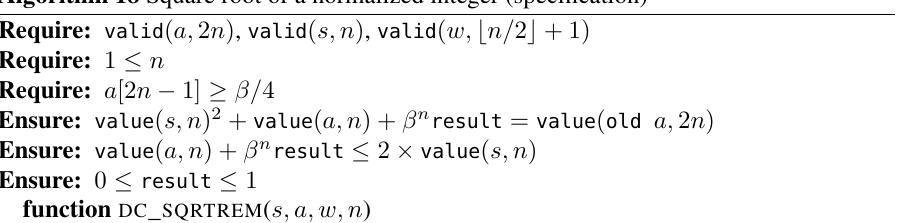
Algorithm 18 Square root of a normalized integer